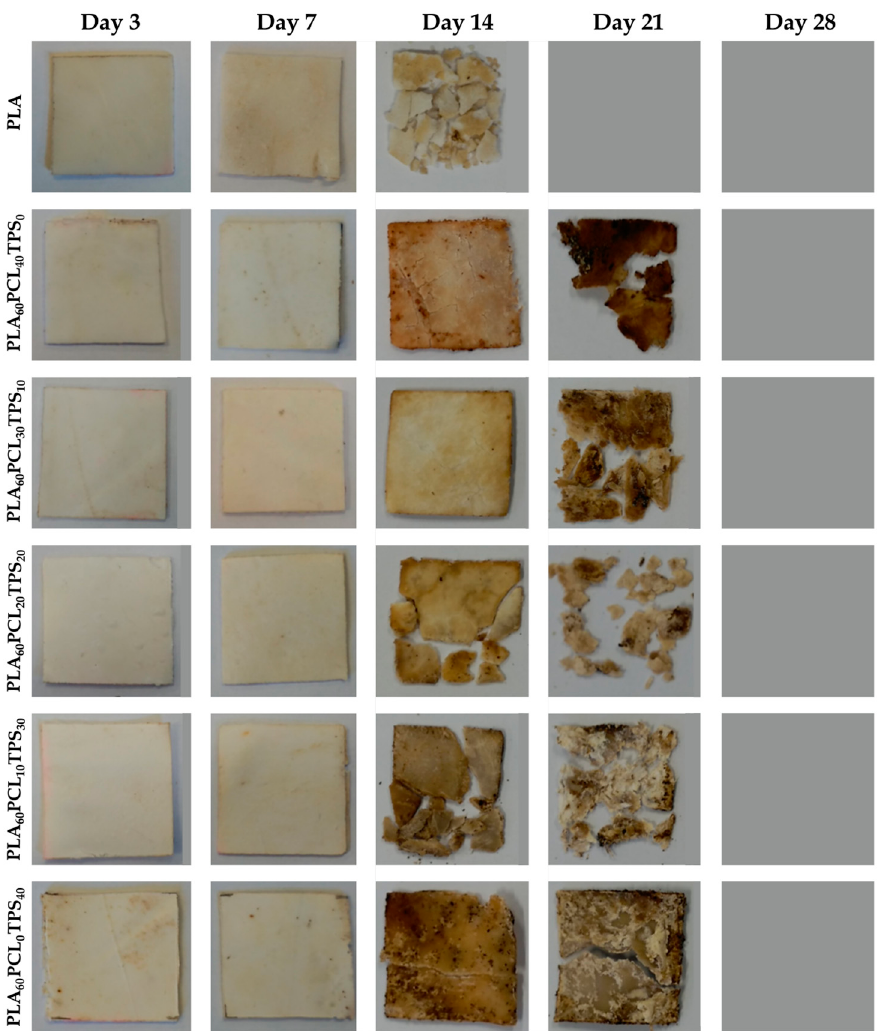
Figure 9. Visual aspect at selected disintegration times of the polylactide (PLA), poly( ε -caprolactone) (PCL), and thermoplastic starch (TPS) blend pieces.